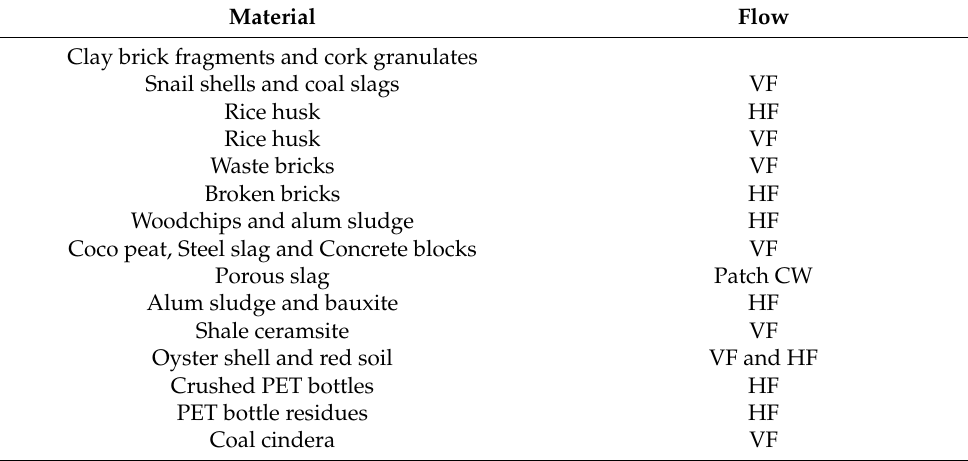
Table 3. Examples of novel filtration materials used in CW are summarized by Vyzamal et al., 2021 [73].